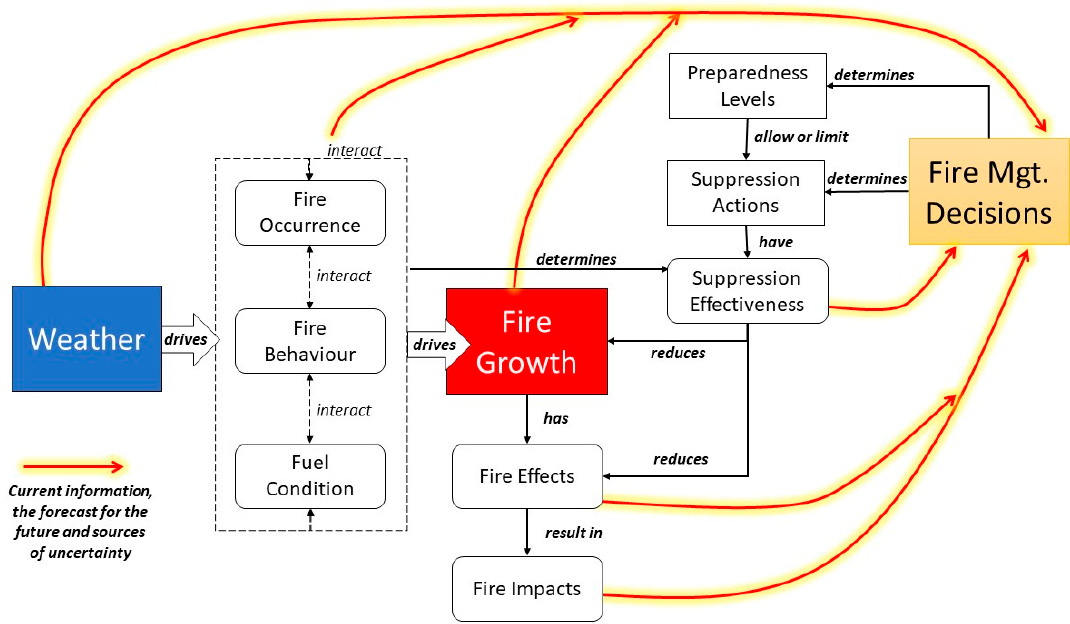
Figure 3. Drivers and interactions among three core elements of the wildland fire system, namely weather, fire growth, and fire management decisions.